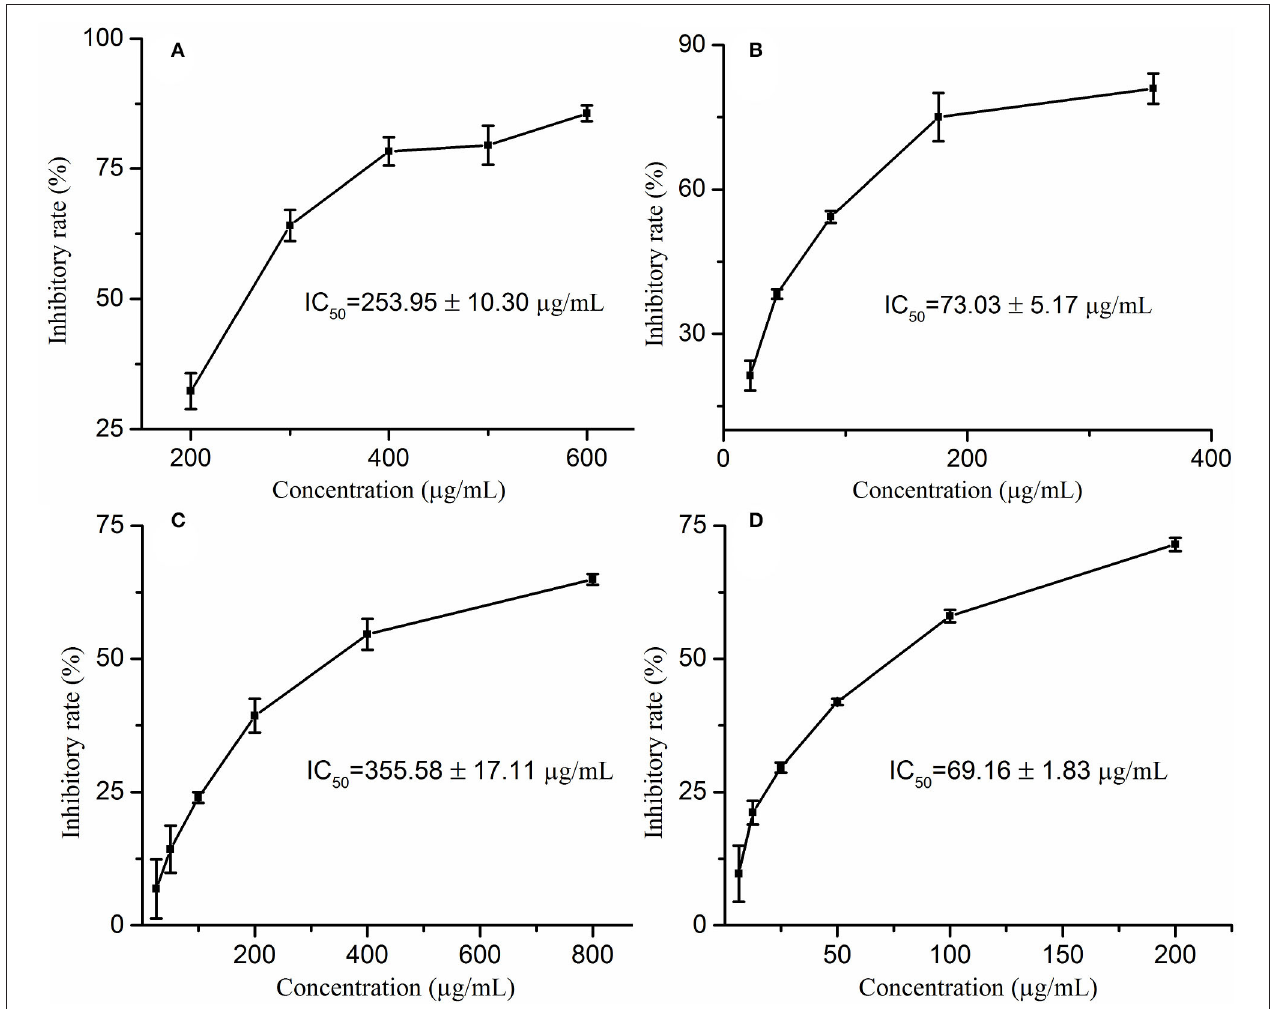
FIGURE 1 | The inhibitory rates of Moringa oleifera leaf extracts on elastase (A) and collagenase (C) as well as their corresponding positive drugs ascorbic acid (B) on elastase, EGCG (D) on collagenase.